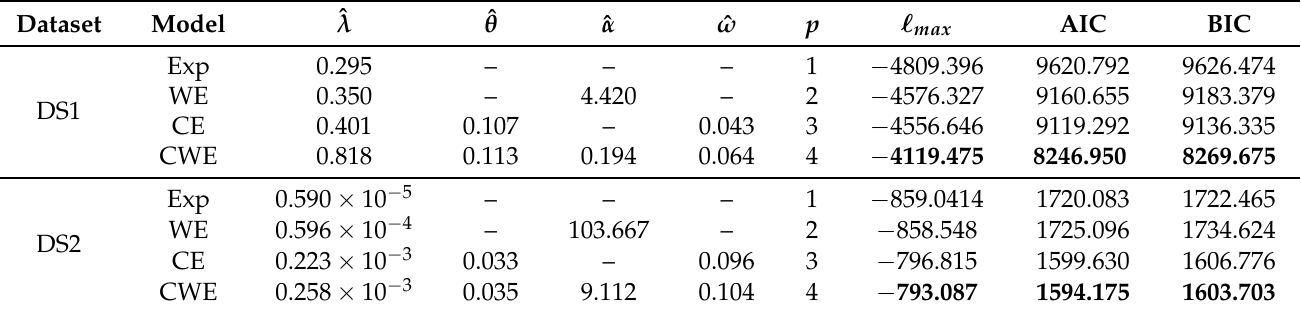
Figure 5. Posterior probability that each observation is unusual, corresponding to the DS2 dataset. Left panel is for the first 74 observations and right panel for the six last observations. Table 3. Summary results from fitting various models to the data. The bold entries highlight the smallest AIC and BIC values for each